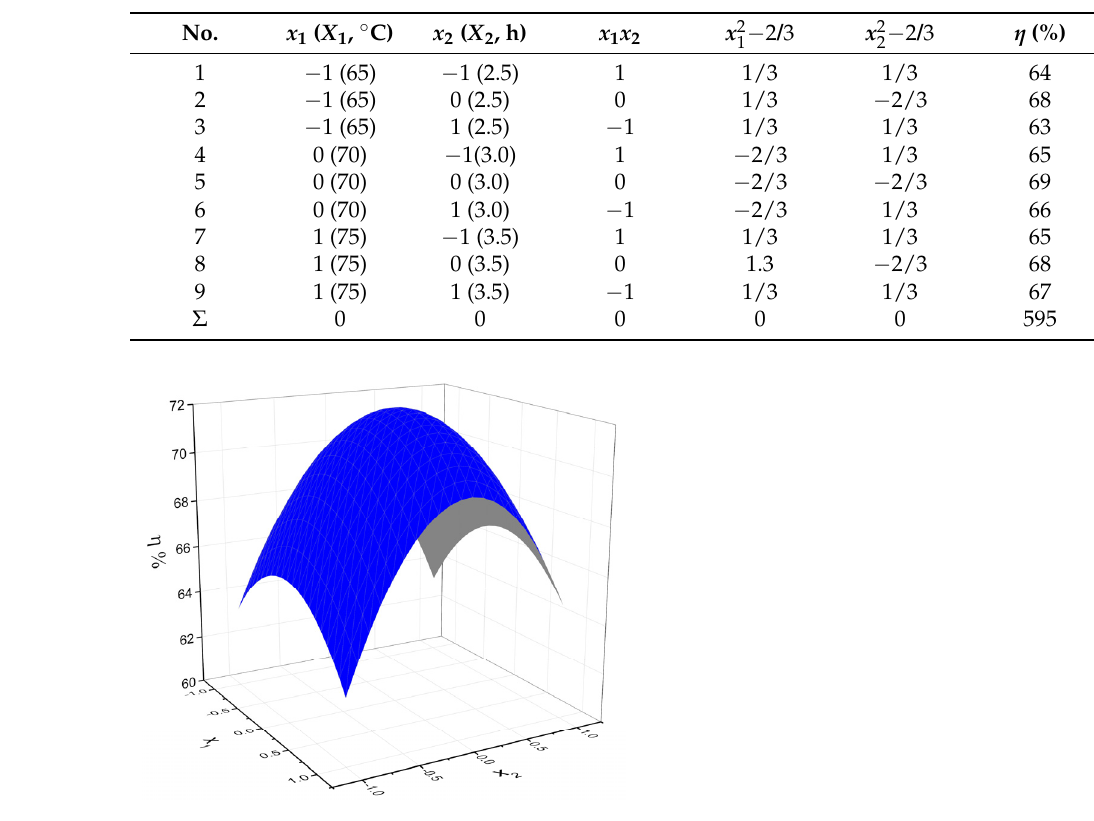
Figure 1. Yield map obtained for molecule VIII.